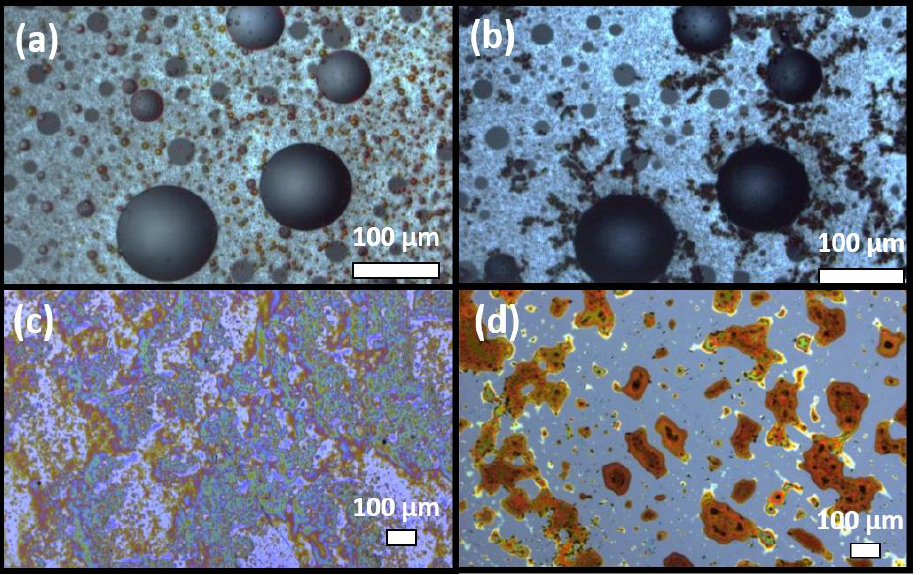
Figure 9. Microscopic images of the colorimetric ethanal-sensitive solution before ( a ) and after ( b ) exposure to ethanal gas for 8 s and of the molecular-binding ethanal-sensitive solution before ( c ) and after ( d ) exposure to ethanal gas for 8 s.